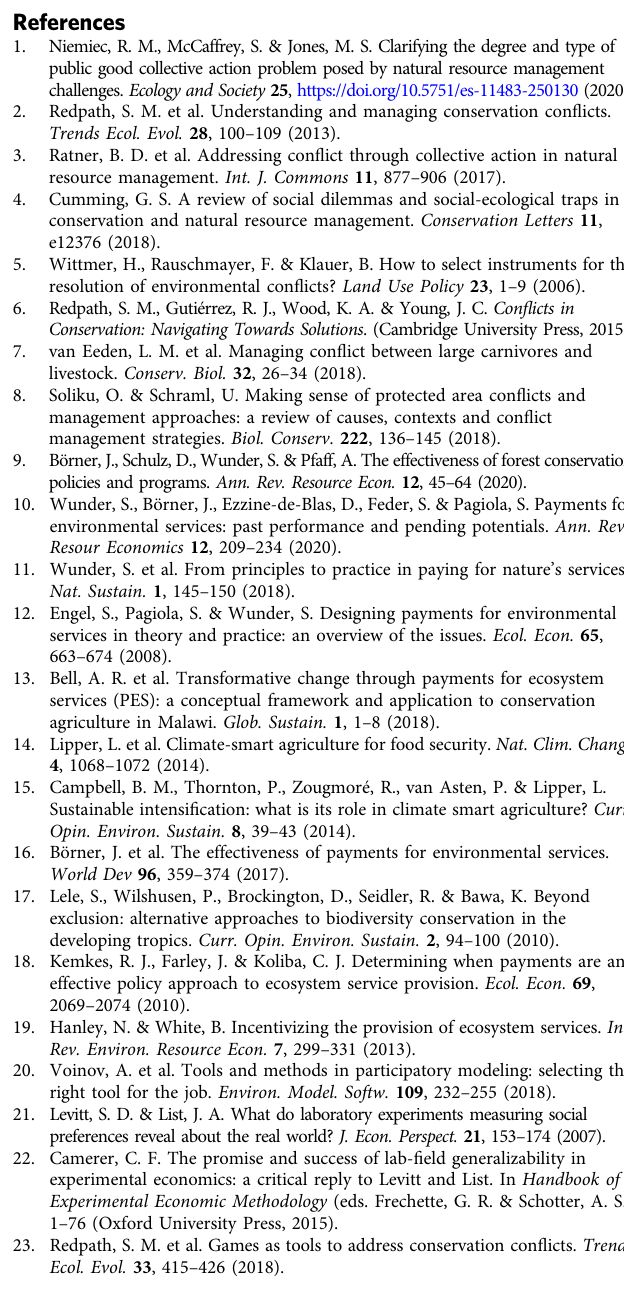
Fig. 4 Examples of spatial equilibria in NetLogo games from NonCropShare. a Heavy spray Nash equilibrium; b Light spray and non-crop habitat cooperative equilibrium; and c Disrupted cooperative equilibrium. Adapted from Bell and Zhang,